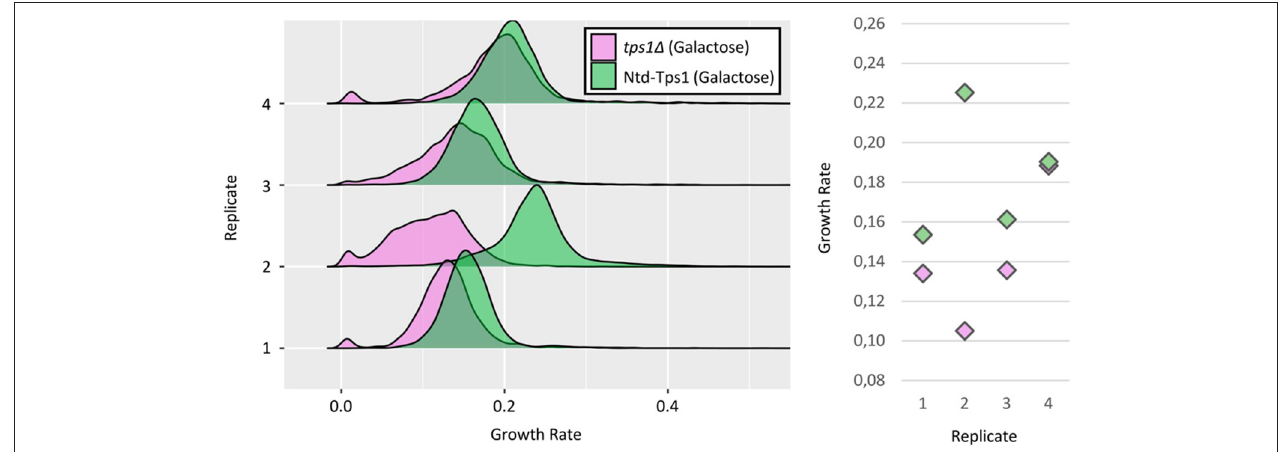
FIGURE 6 | Growth phenotype of the tps1 1 strain at the single-cell level. (Left) Growth rates distributions of tps1 1 cells (pink) and control, Ntd-Tps1 cells (green), with galactose as carbon source, from four independent replicates. Growth rates calculation as in Figure 3 . (Right) Median growth rates of the distribution for tps1 1 and Ntd-Tps1 cells, respectively: replicate #1 ∼ 0,13 and ∼ 0,15 h − 1 ; replicate #2 ∼ 0,10 and ∼ 0,22 h − 1 ; replicate #3 ∼ 0,13 and ∼ 0,16 h − 1 ; replicate #4 ∼ 0,18 and ∼ 0,19 h − 1